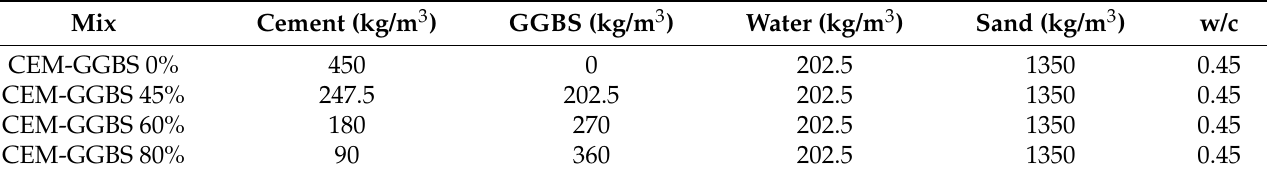
Table 2. Mortar mixes and corresponding content